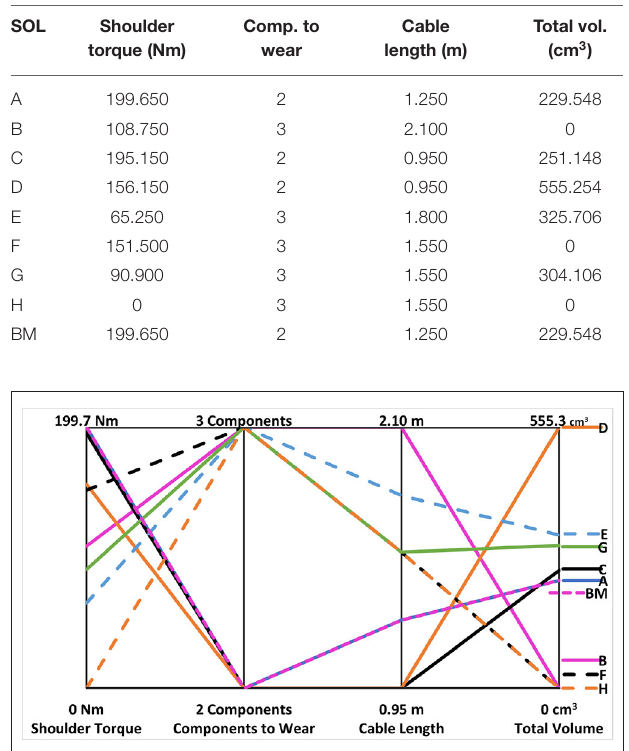
FIGURE 3 | Results of the Pareto analysis applied to the 8 hybrid configurations (preliminary presented in Piazza et al., 2017), considering 4 indices: (1) the shoulder torque, (2) the number of elements to wear, (3) the cable length and (4) the total volume occupied by the components included in the socket. NB: values for the benchmark are presented by the dashed, magenta line labeled “BM”.